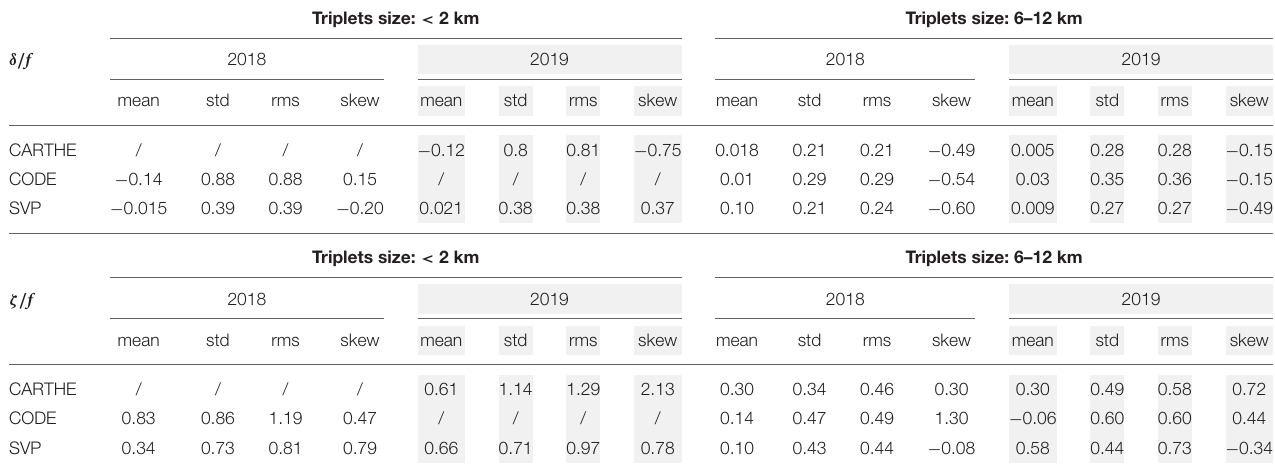
TABLE 2 | Statistical results for the normalized divergence ( δ/ f ) and vorticity ( ζ/ f ) distribution ( top and bottom panel, respectively) for the 3 types of drifters in the ranges < 2 and 6–12 km for years 2018 and 2019. Triplets size: < 2 km Triplets size: 6–12